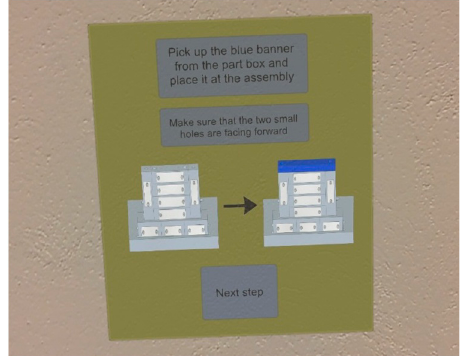
Figure 8. Snapshot of the UI-Panel taken from the HoloLens.